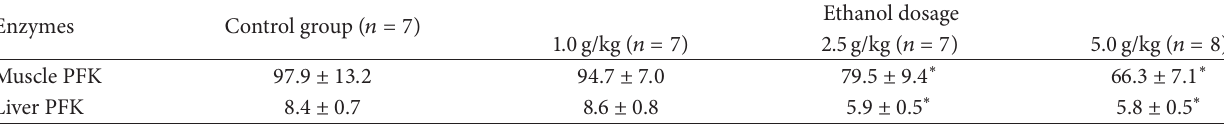
Table 1: Activities (nmol/mg/min) of muscle and liver phosphofructokinases after the acute alcohol intoxication. Enzymes